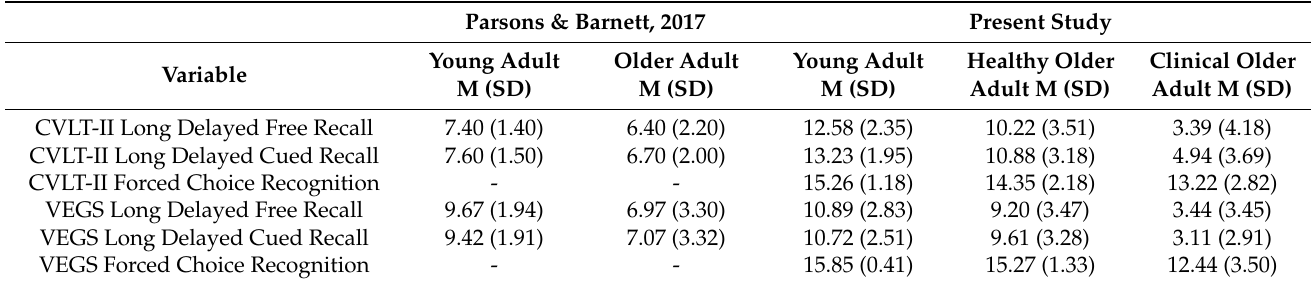
Table A1. Comparison of group performance on neuropsychological measures [28].